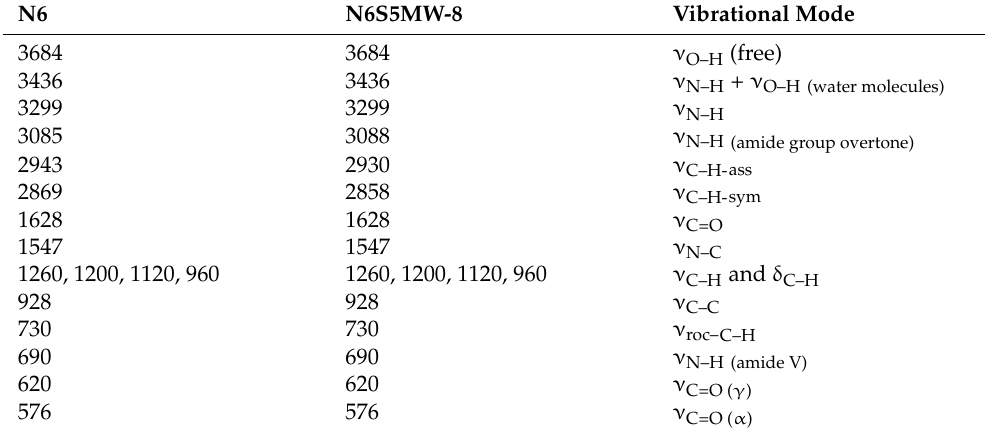
Table 2. FT-IR bands positions (cm − 1 ) and ascriptions of N6 and